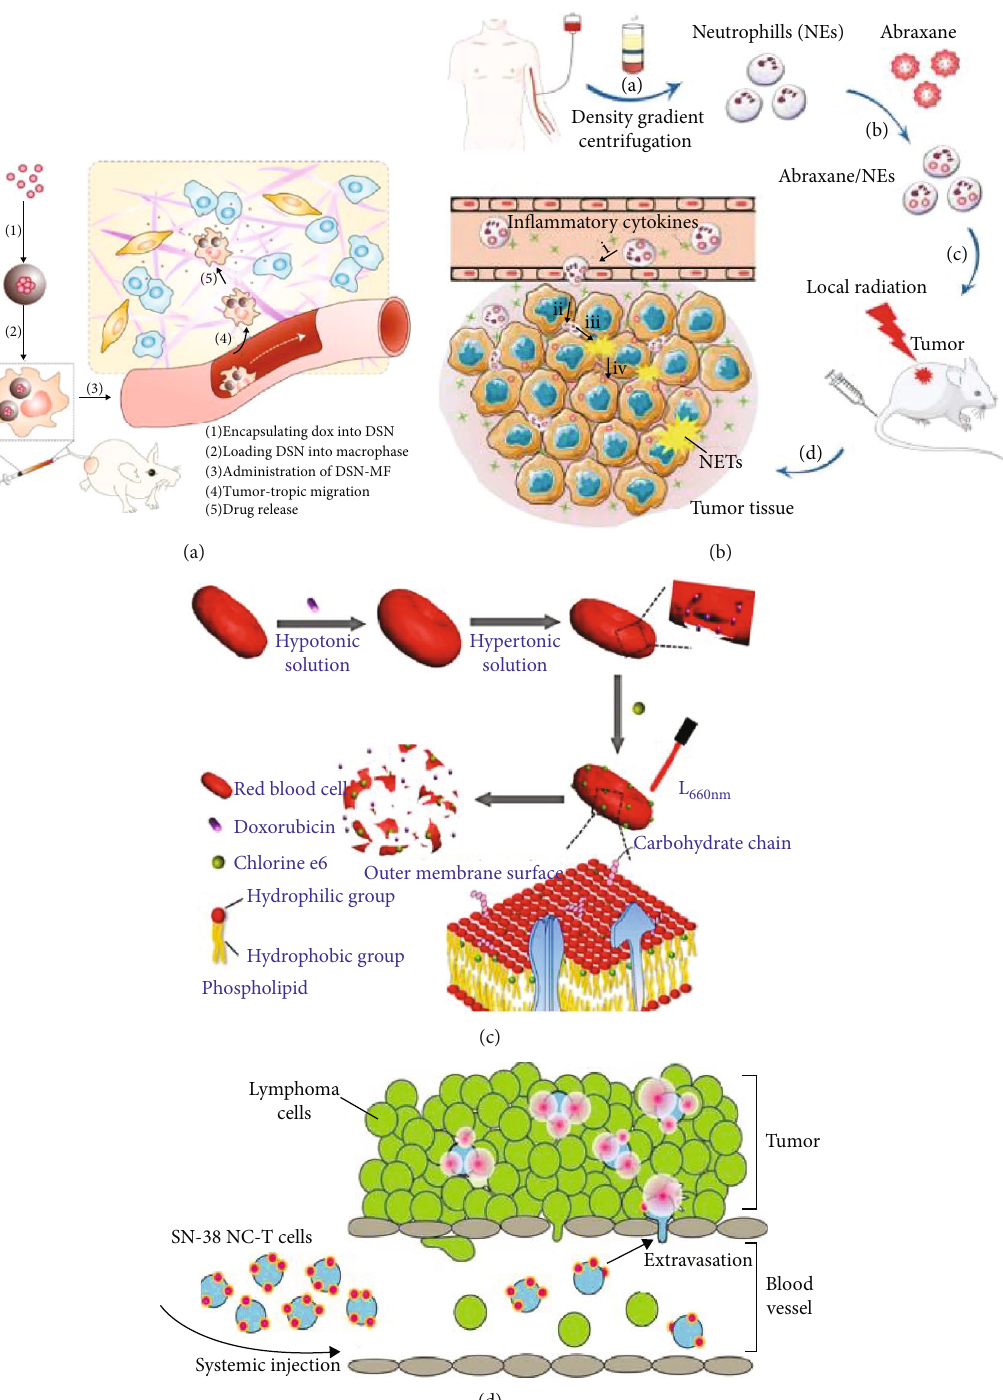
Figure 4: Three drug release patterns. (a) Exocytosis: either free Dox or Dox/SiO NPs were secreted by MAs for glioblastoma treatment. 2 Reproduced with permission [18]. Copyright 2018. John Wiley and Sons. (b) Cell disintegration I: Abraxane-encapsulated NEs disintegrated and formed the neutrophil extracellular traps to kill gastric cancer. Reproduced with permission [38]. Copyright 2018. John Wiley and Sons. (c) Cell disintegration II: Dox-encapsulated and Ce6-backpacked RBCs were disintegrated by photoradiation for breast cancer. Reproduced with permission [46]. Copyright 2017. American Chemical Society. (d) Cell-drug dissociation: SN-38 was dissociated from the T cell membrane into lymphoma cells. Reproduced with permission [12]. Copyright 2015. American Association for the Advancement of